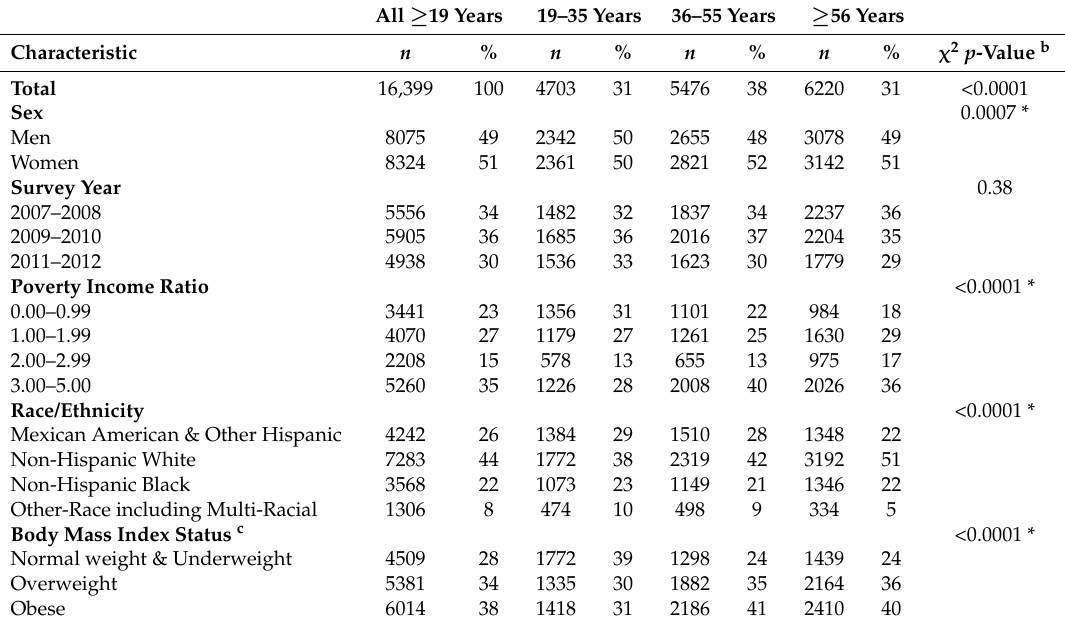
Table 1. Characteristics of U.S. adults ≥ 19 years using NHANES 2007–2012 a